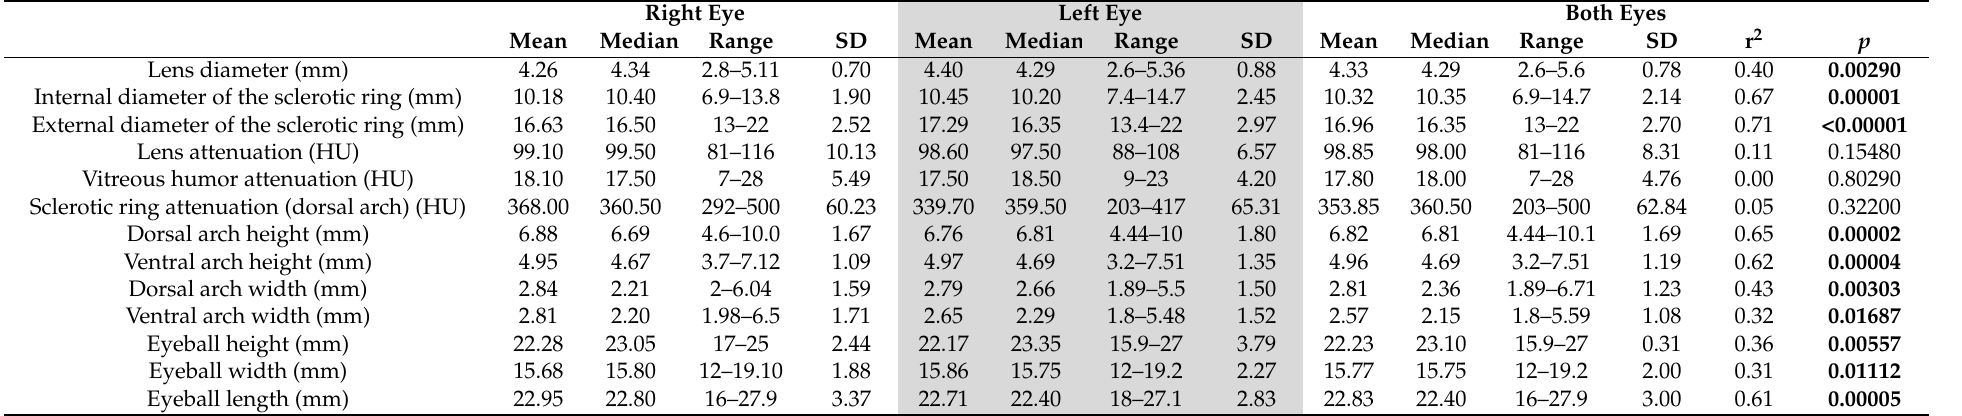
Table 1. Measurements of the right and left eye of the loggerhead